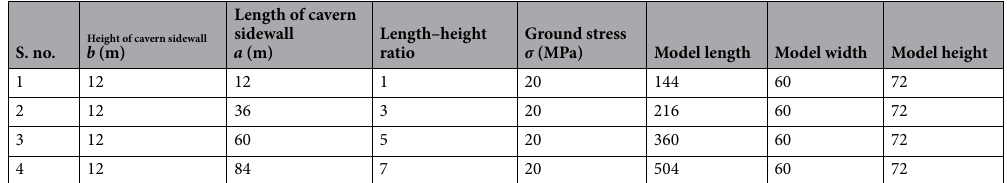
Table 3. Numerical calculation model parameters.